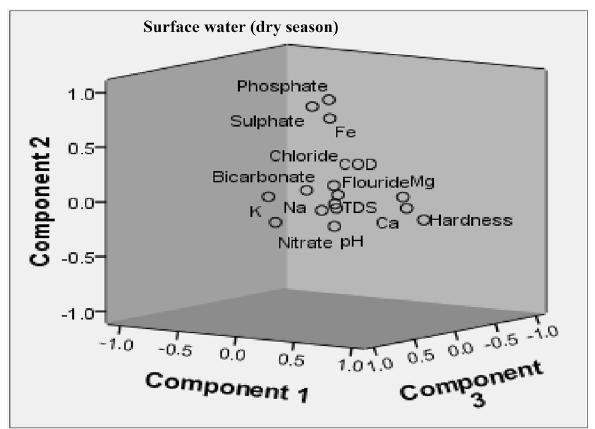
Fig. 6 Principal component analysis (PCA) for the selected SW sources in the dry